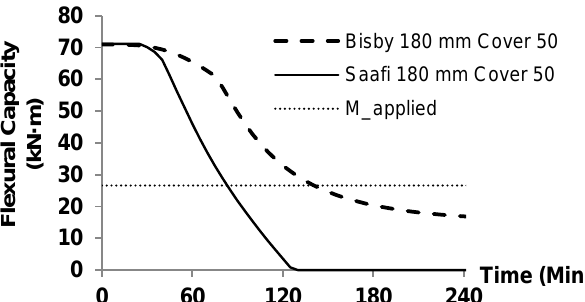
Figure 5. Moment curves using different FRP degradation model in high temperature.